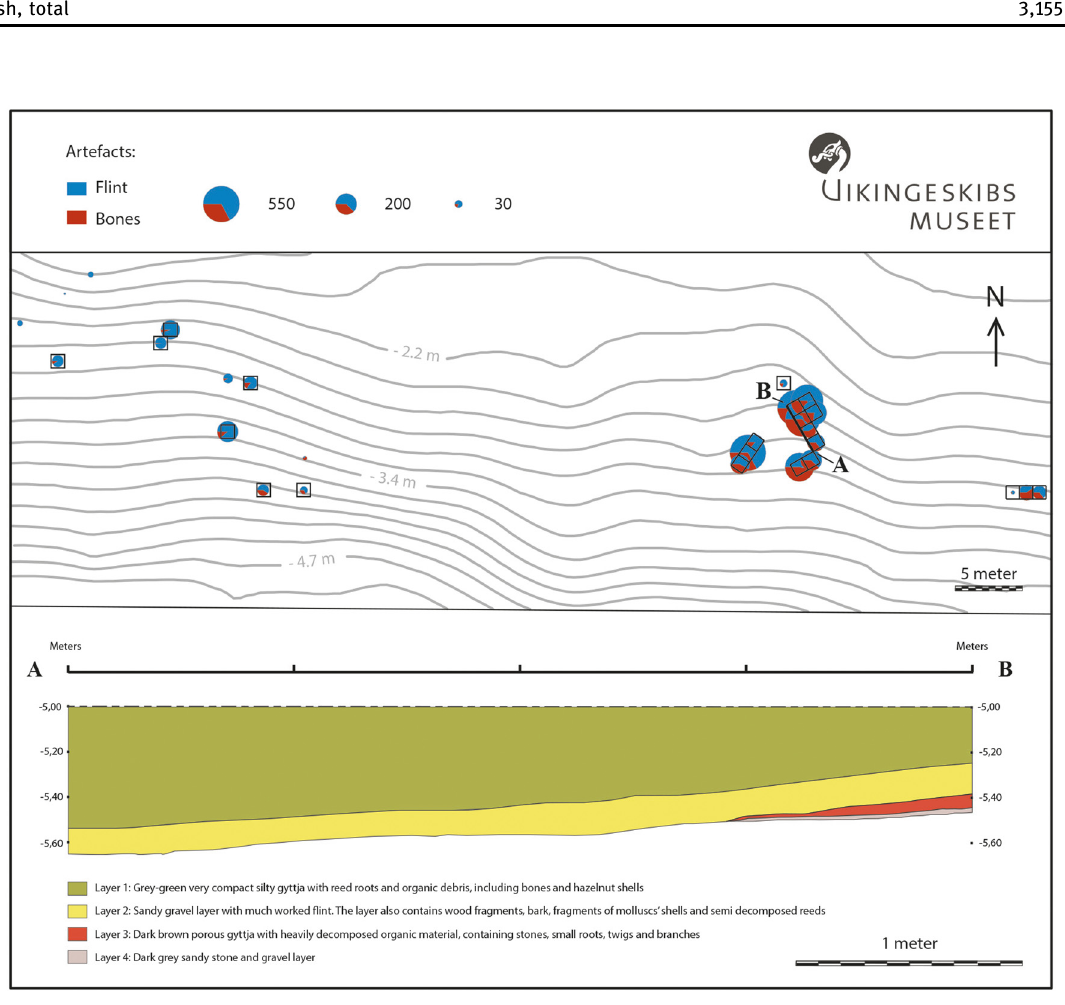
Figure 6: Kalverev, Lokalitet X , site plan and pro fi le. Contour lines represent the depth of the seabed. As several meters of sediment were removed with mechanical excavator prior to diver excavations, the pro fi le only shows the one meter of sediment above moraine till that was left by the